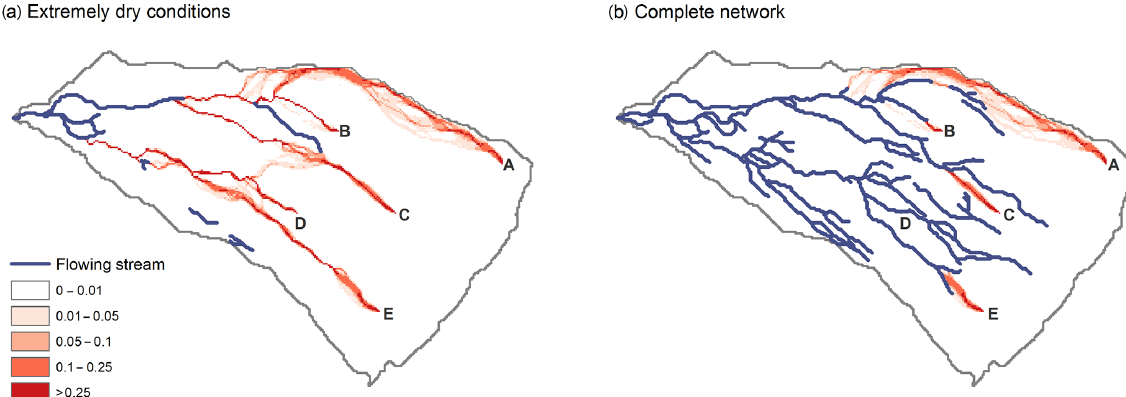
Figure 3. Maps showing subsurface flow pathways starting from five selected pixels (in red; A–E) and the flowing stream network (in blue) observed during extremely dry conditions and for the complete network (assumed to represent extremely wet conditions). Darker colors indicate a larger fraction of the flow. The shorter flowing stream network under dry conditions implies much longer subsurface flow pathways from most points on the landscape. The subsurface fractions of the total travel distance to the outlet ( L h /L t , mm − 1 ) for the extremely dry and complete network are A: 0.66 and 0.44; B: 0.48 and 0.07; C: 0.59 and 0.15; D: 0.74 and 0.01; E: 0.81 and 0.11, respectively. Table 2. Statistics for the travel time distributions ( t t ) as well as the median subsurface ( t h ) and surface ( t s ) travel times, and the fraction of the catchment with travel times shorter than or equal to 1 or 2d, for the five different stream networks using a subsurface velocity ( v h ) of 5 × 10 − 4 ms − 1 and surface velocity ( v s ) of 0.5ms − 1 . See Fig. 2 for the maps with the stream networks and Fig. 4 for the travel time distributions and maps of the areas with travel times shorter than or equal to 1 or 2d. Mapped stream networks Extremely Dry Wetting- Complete Topographic dry up network map Travel time Mean